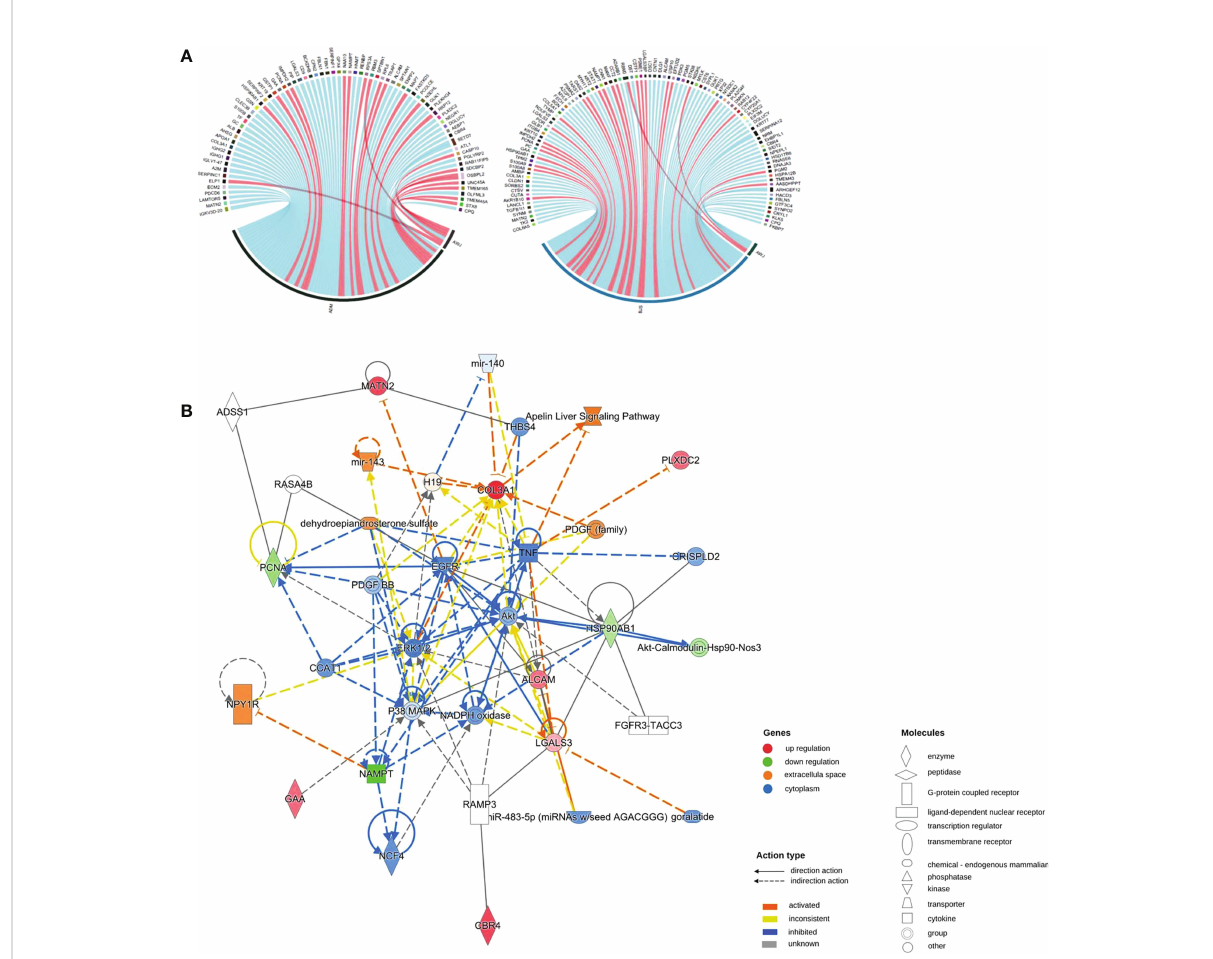
FIGURE 3 (A) Correlation between DEPs and clinical improvement. Circos plot presenting the Pearson correlation between DEPs and the PASI score (|cor| >0.6, p value<0.05). Red ribbons indicate positive Pearson correlation coef fi cients, namely, the downregulation of protein. Blue represents negative Pearson correlation coef fi cients, that is, the upregulation of protein. The width of the ribbons indicates the correlation value. (B) Causal network analysis obtained by IPA of eleven proteins that changed signi fi cantly in both biological agent groups in DIA. The highest-score network (containing ten proteins, except IMPDH2) is displayed only for the secukinumab group because the relationship patterns of the proteins in the two groups were similar. The relationship among molecules is represented by lines (solid lines for direct association and dotted lines for indirect